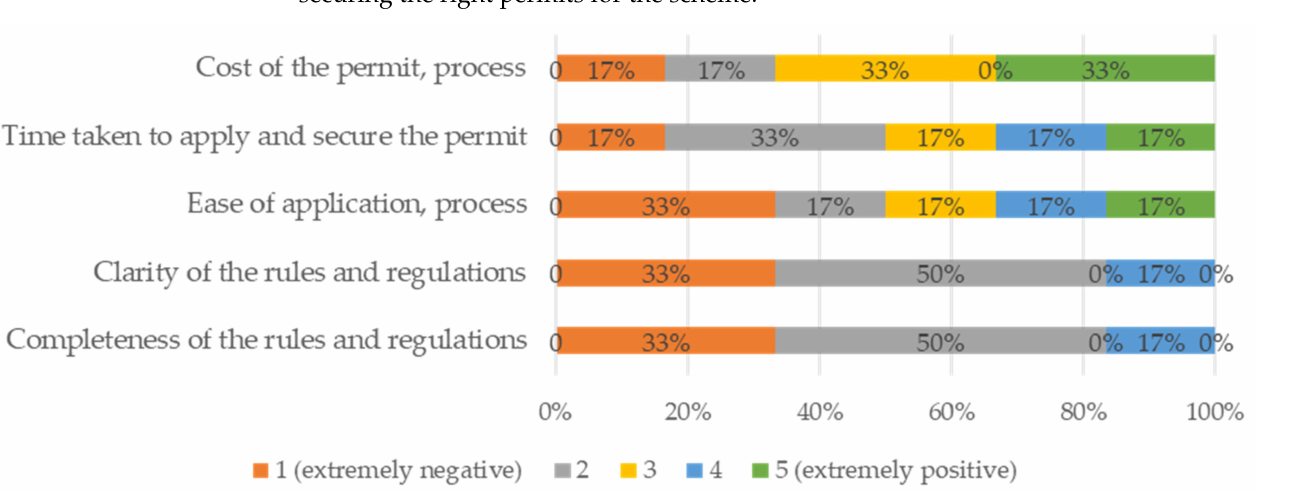
Figure 3. Participants’ ranking of the factors associated with securing the right permits for the